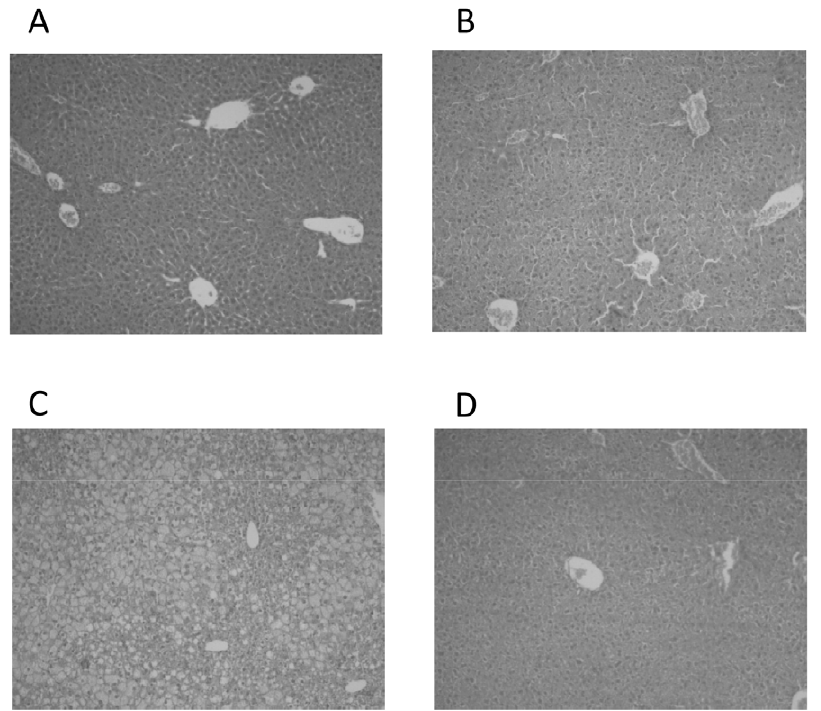
Figure 1. Effect of n-3 long-chain polyunsaturated fatty acid ( n-3 LCPUFA) supplementation on liver histology. Representative liver sections from animals given (A) control diet, (B) control diet plus n-3 LCPUFA, (C) HFD, and (D) HFD plus n-3 LCPUFA (hematoxylin-eosin liver sections from a total of 9 animals per experimental group; original magnification 6 40).